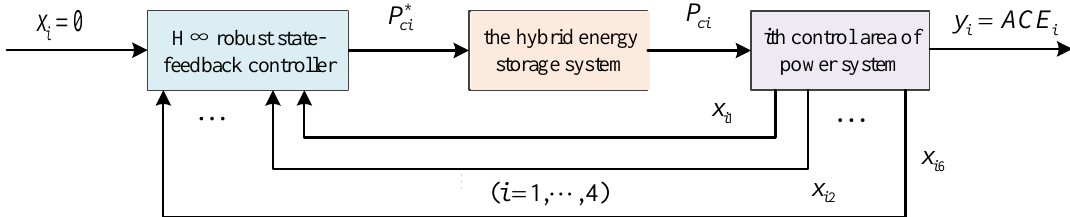
Figure 6. H ∞ robust state feedback control for the i th control area.